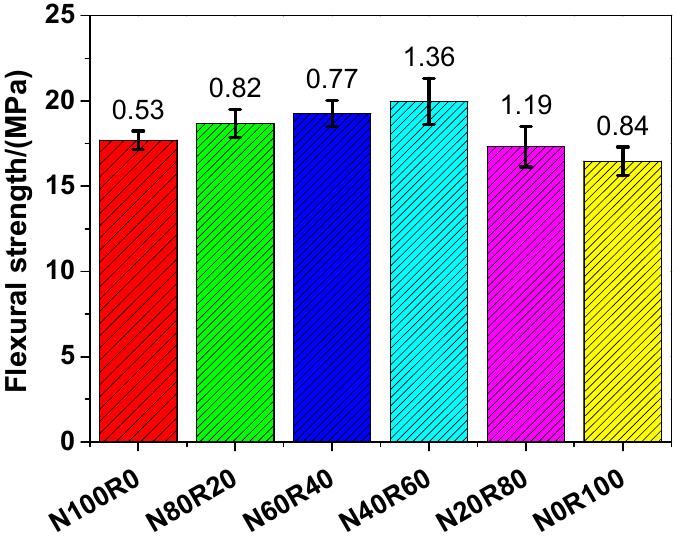
Figure 8. Four-point flexural strength of UHPC.